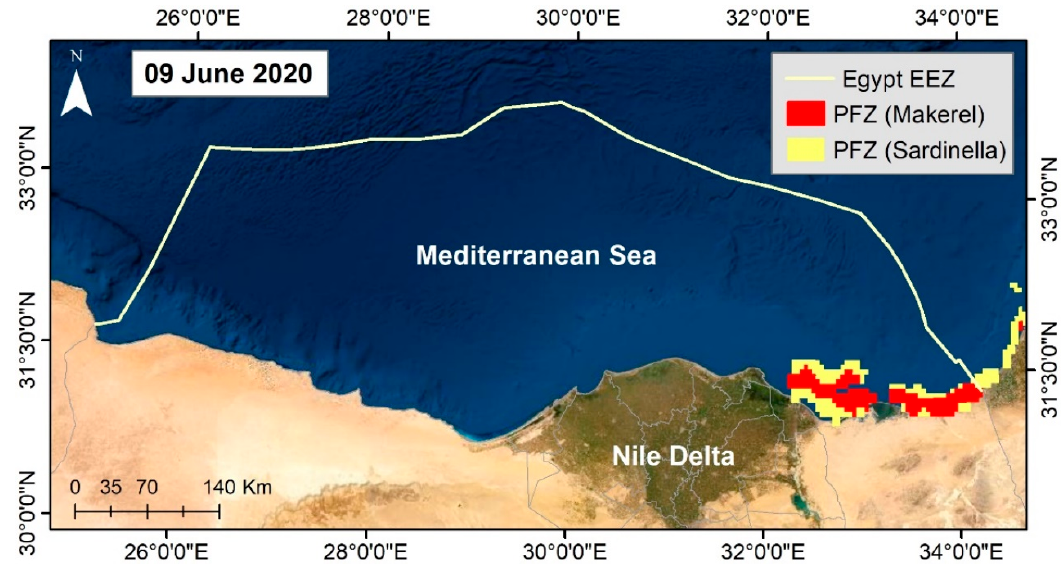
Figure 14. PFZ for Sardinella aurita and Makerel Tuna on 9 June 2020.